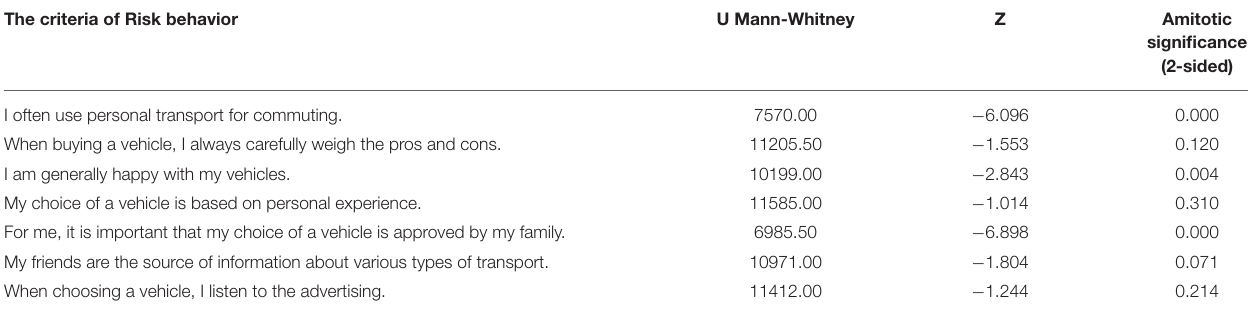
TABLE 2 | Comparison of Russian and Chinese samples by risk behavior criteria. The criteria of Risk behavior